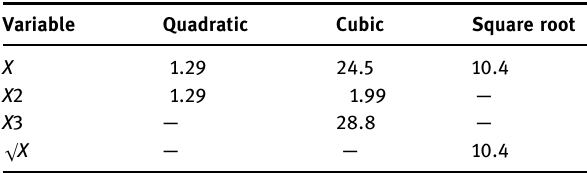
CBD yield Table 3: Variance in fl ation factor ( VIF ) of the X , X 2, X 3, and √ X in the quadratic, cubic, and square models centered independent vari - ables. X = N fertilizer rate Variable